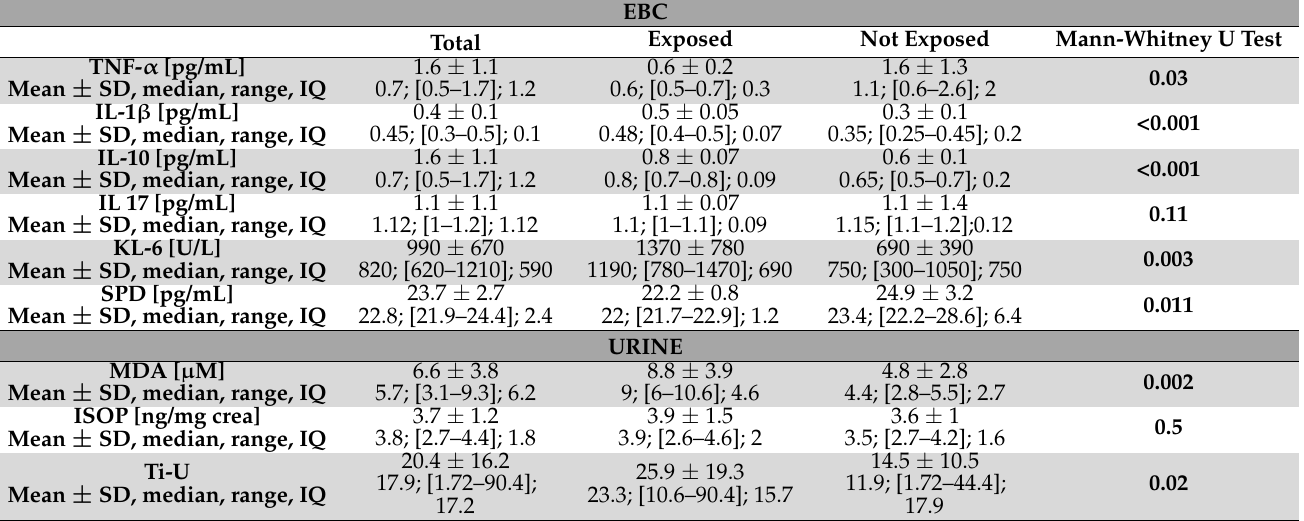
Table 4. General descriptive biomarkers measured in EBC and urine sample with Mann–Whitney U test